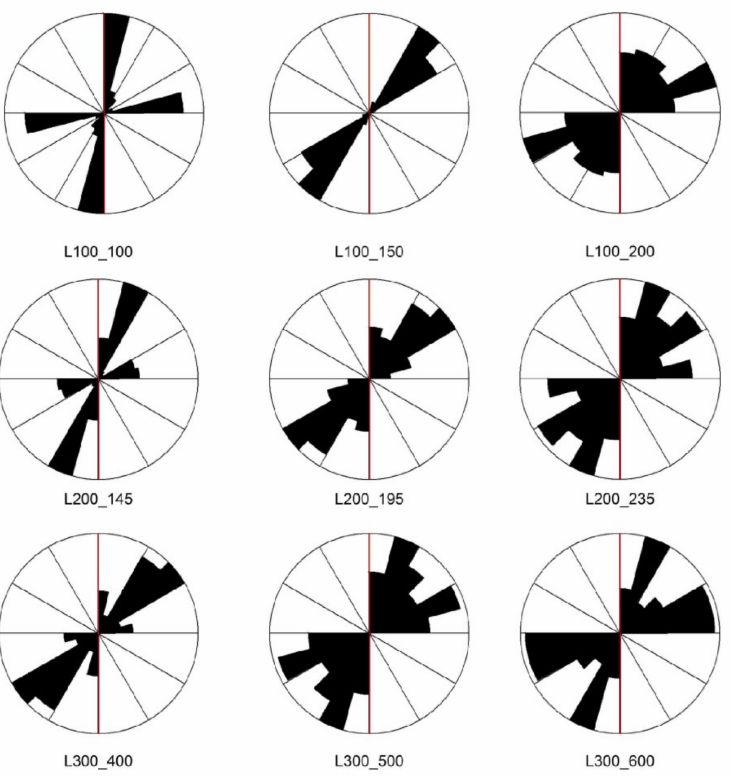
Figure 3. Multi-frequency rose diagrams of geoelectric strike direction of some stations by using the Goom–Bailey (GB) decomposition.